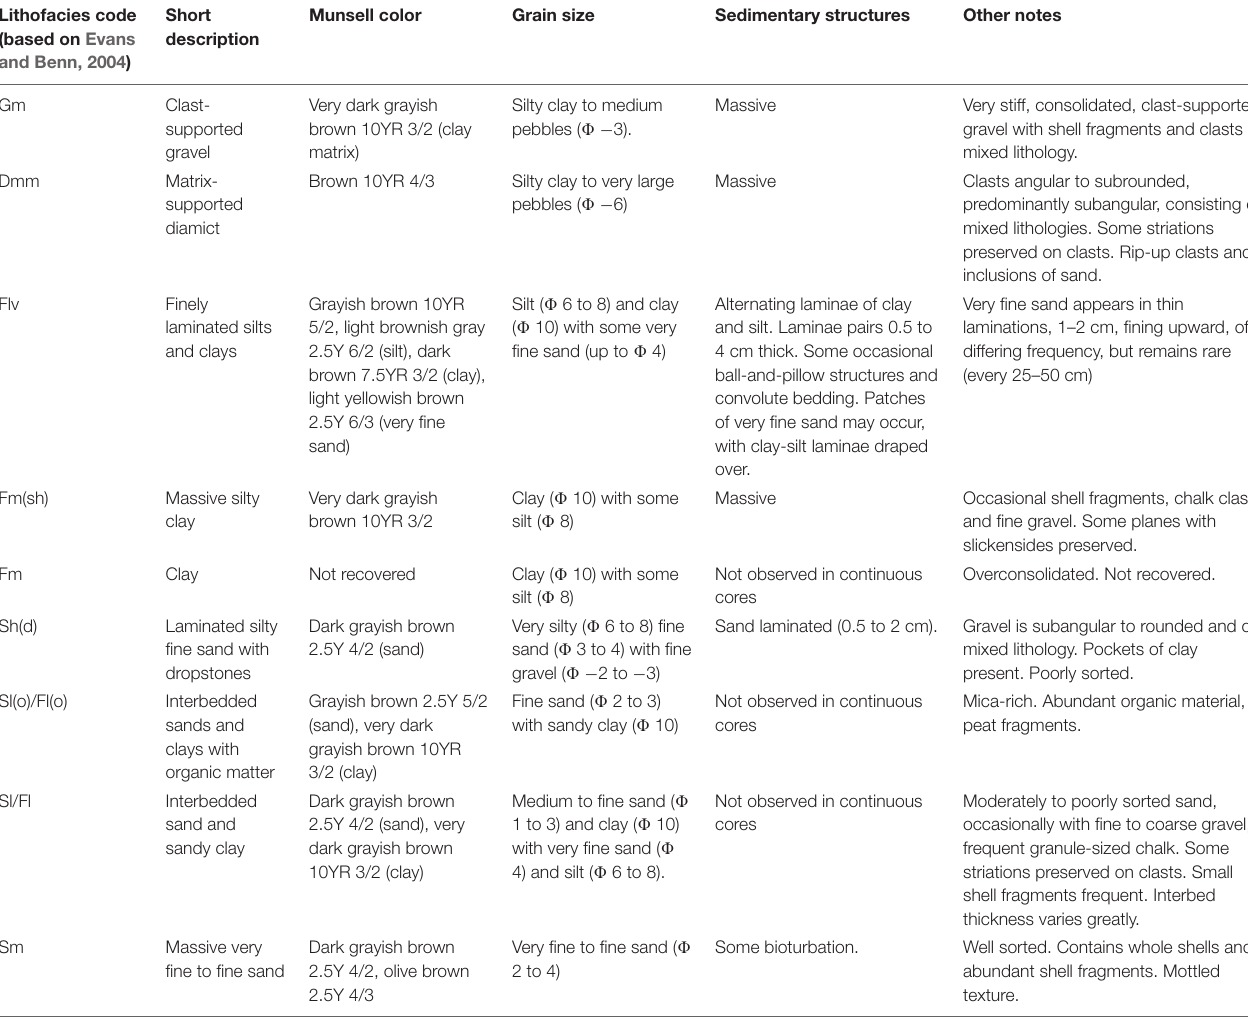
TABLE 4 | Lithofacies descriptions as observed in vibrocores and borehole